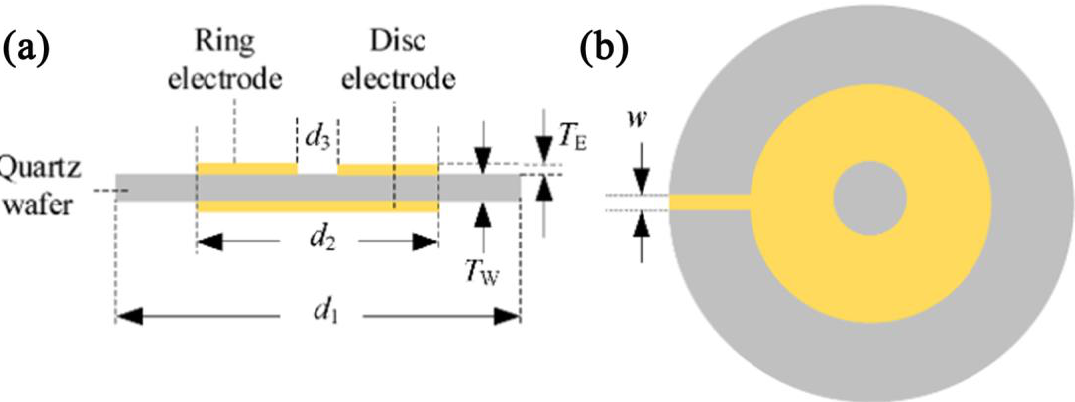
Figure 17. Structure of QCM element: side view ( a ), top view ( b ). Reproduced with permission from Ref. [140]. Copyright 1996 – 2022, MDPI, Basel, Switzerland.